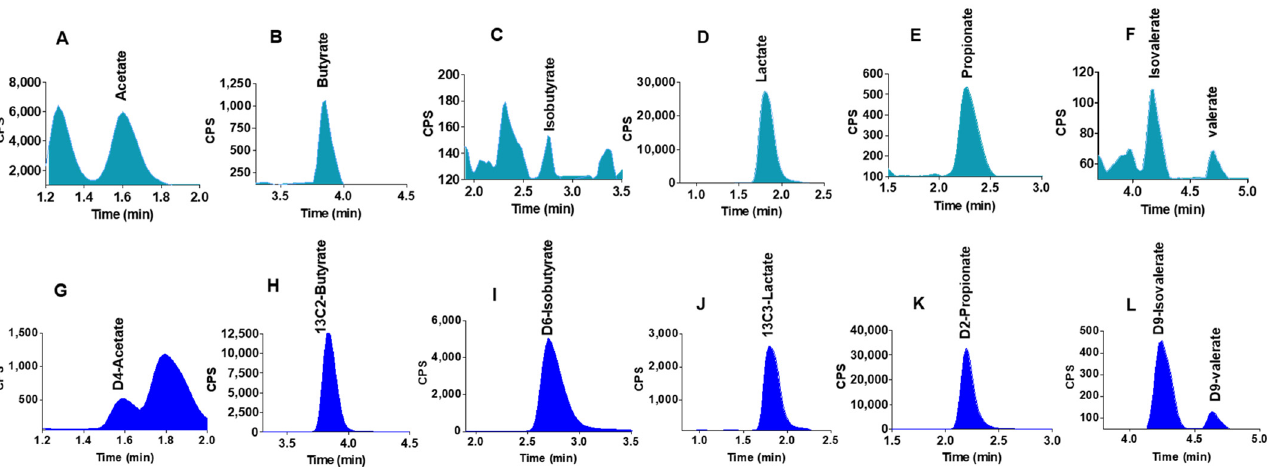
Figure 2. LC-MS generated SCFA peaks in colon model fermentation samples. ( A – F ) peaks detected in colon model fer- mentation samples. ( G – L ) corresponding labelled internal standards of SCFA in colon model samples.